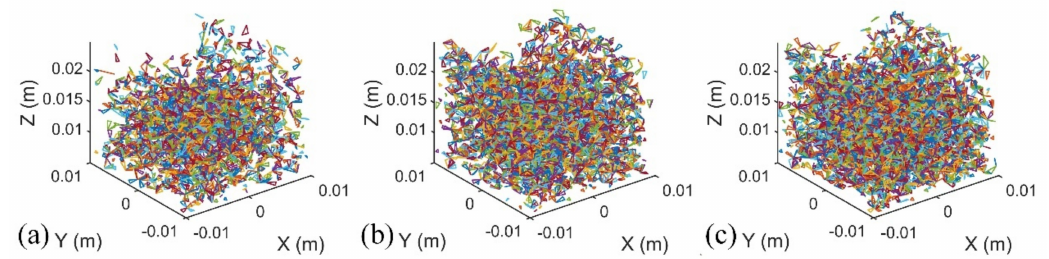
Figure 9. 3-cylces connection for the specimen FC30 at t = ( a ) 0.01 s; ( b ) 0.1 s; and ( c ) 0.2 s.